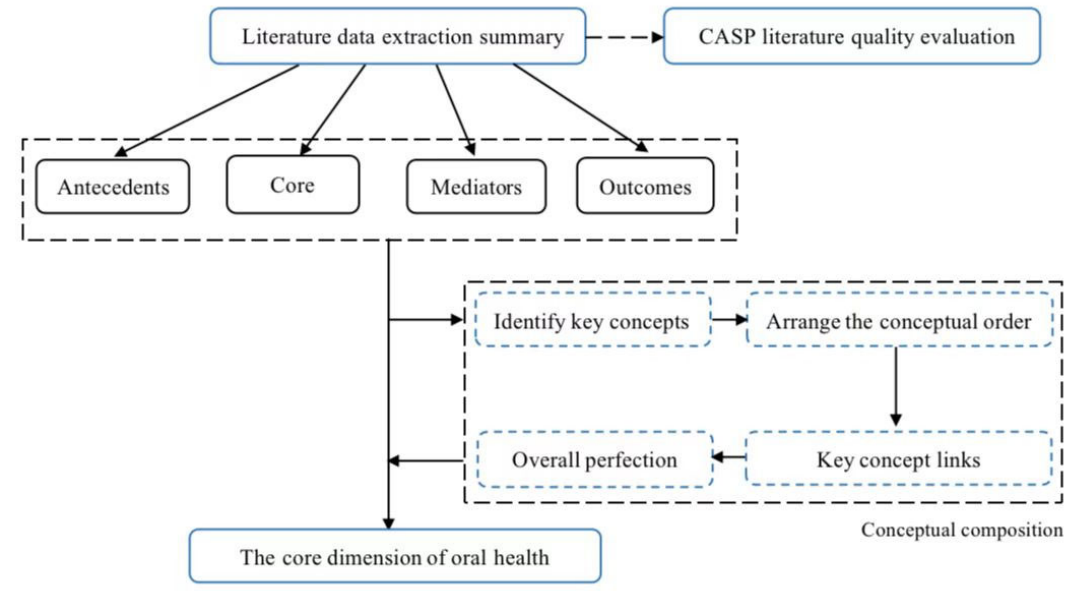
Figure 2. Flowchart for the analysis of the conceptual connotations of OHL.